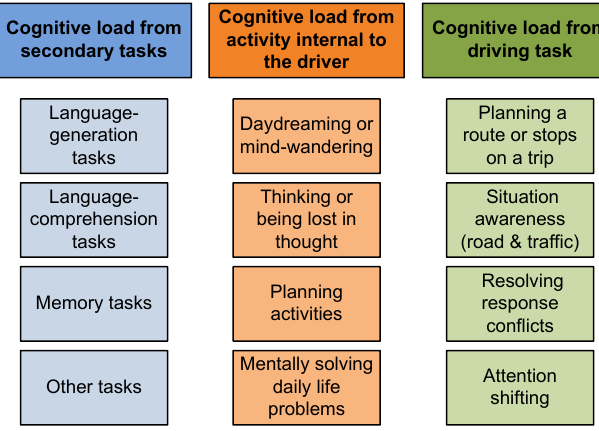
Figure 5. Classification of main types and subtypes of cognitive load while